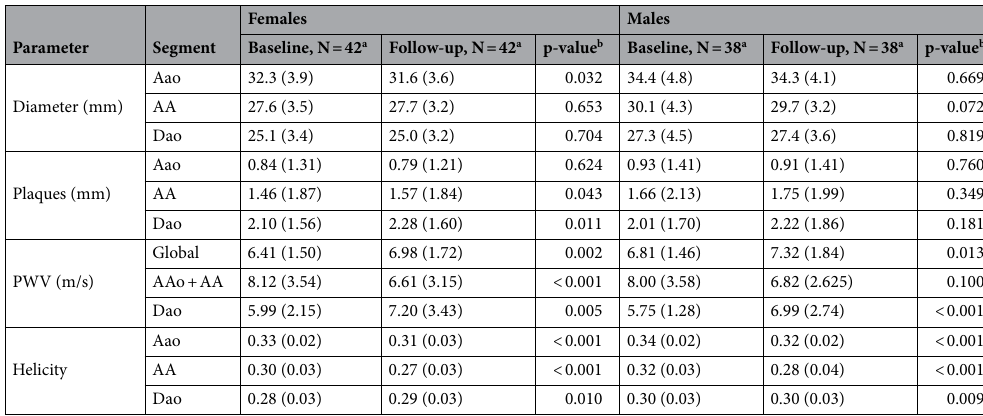
Table 3. Aortic parameters in the 80 participants at baseline and follow-up. N number of subjects, AAo ascending aorta, AA aortic arch, DAo descending aorta, PWV pulse wave velocity. a Mean (± standard deviation). b Wilcoxon signed rank test.